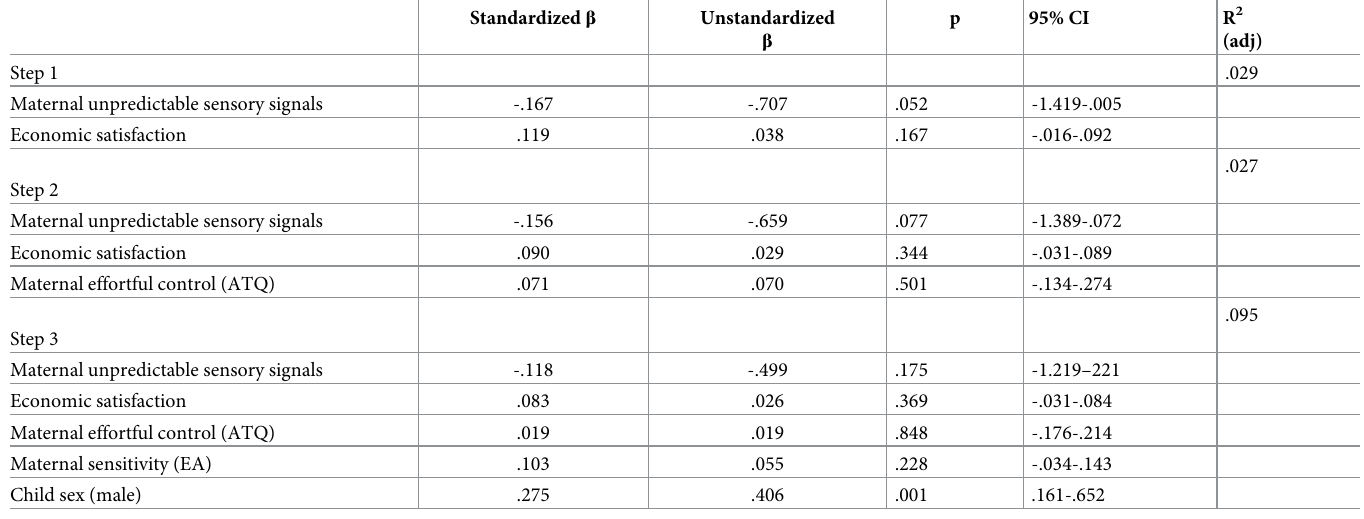
Table 3. Standard linear regression for child effortful